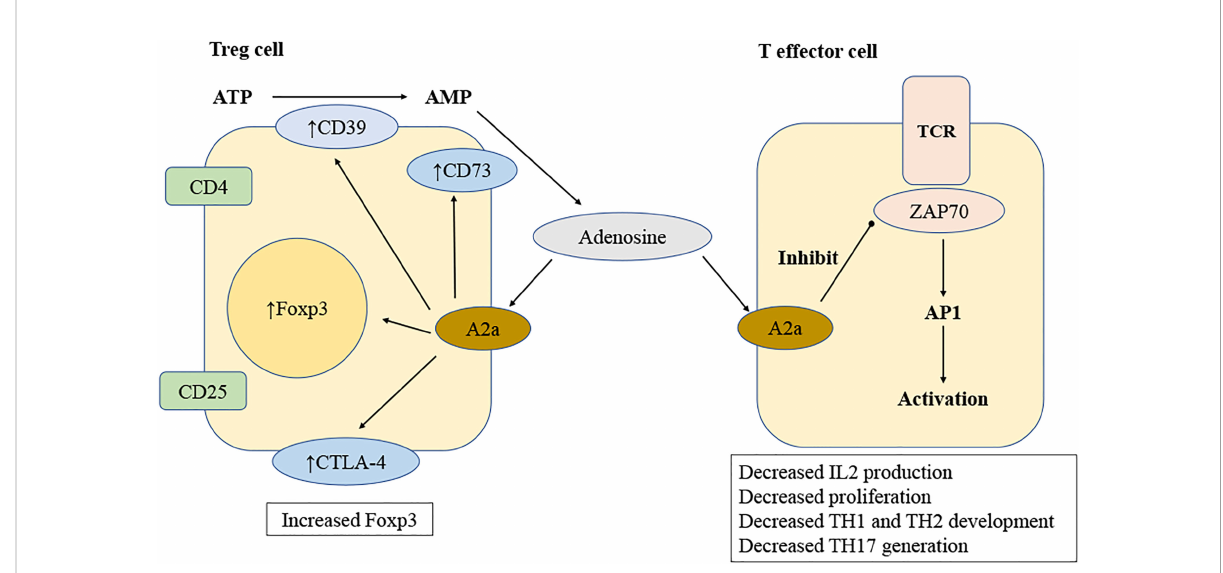
FIGURE 3 Mechanisms of adenosine regulation of T lymphocyte. Adenosine is produced by regulatory T (Treg) cells when ATP is degraded sequentially by CD39 and CD73. Adenosine stimulates T-effector cells via A2a receptors, therefore inhibiting T cell receptor (TCR) signal by inhibiting ZAP70 phosphorylation and activating the transcription factor activator protein 1(AP-1). Reduced TCR signal results in lower synthesis of IL-2 and expression of CD25, leading to inhibited T cell proliferation. Activating A2a receptors changes the development of T helper 1 (TH1), TH2 and TH17 lymphocytes. The A2a receptor activation of T cells results in an increase CTLA-4, PD-1 and Foxp3